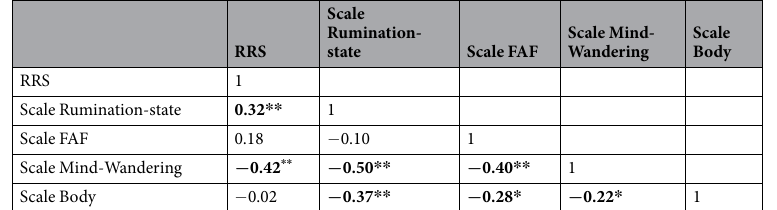
Table 1. Pearson correlations between the resting-state scales and trait rumination. N = 84, * p < 0.05, ** p < 0.001.